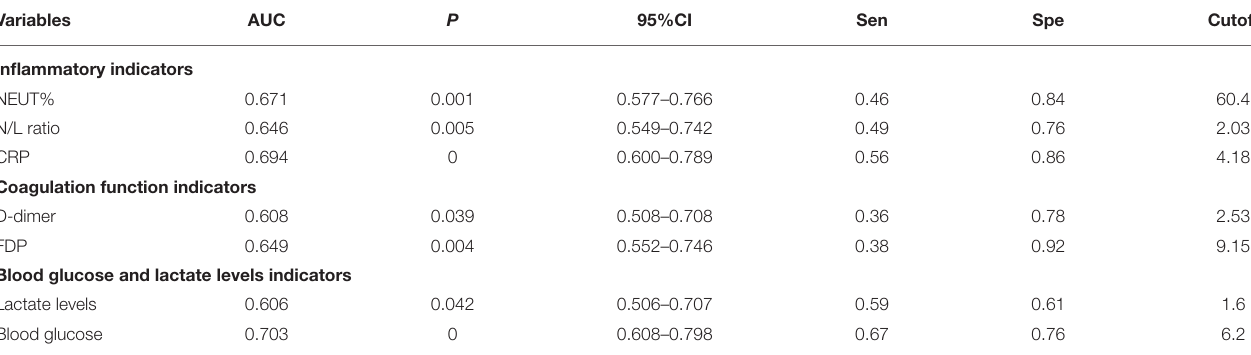
TABLE 3 | ROC values of inflammatory indicators, coagulation function indicators, and blood glucose and lactate level indicators between comparisons of two